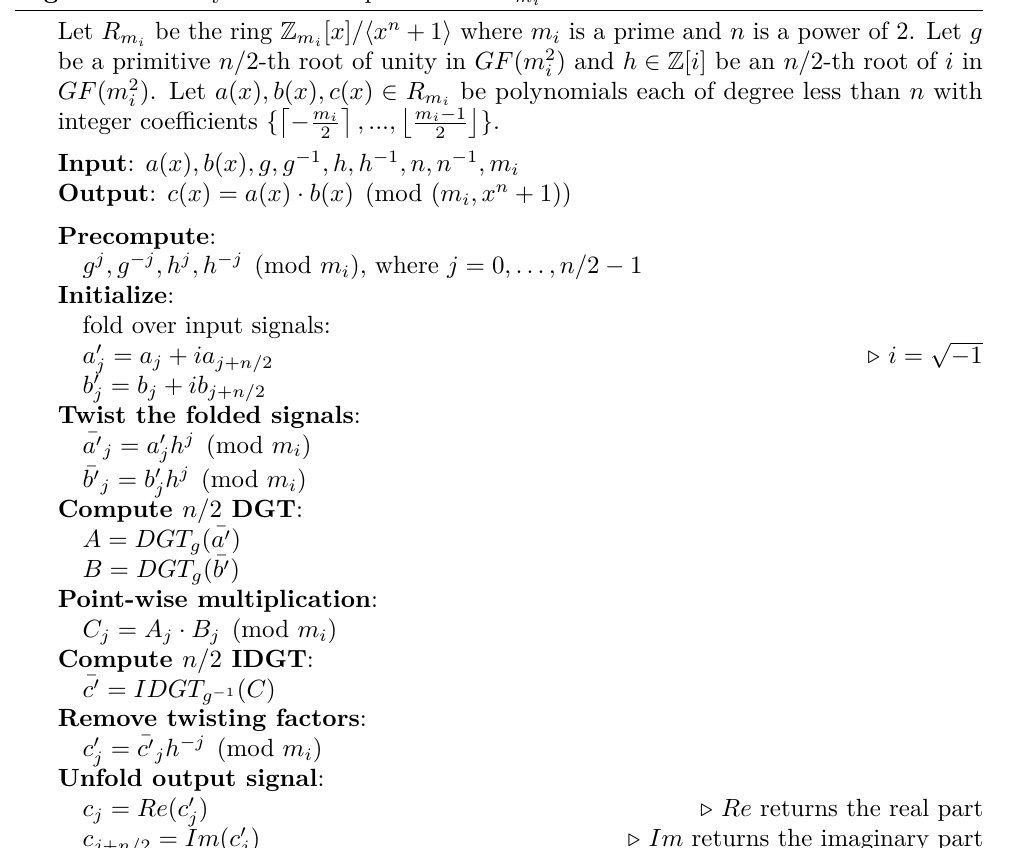
Algorithm 1 Polynomial multiplication in R m